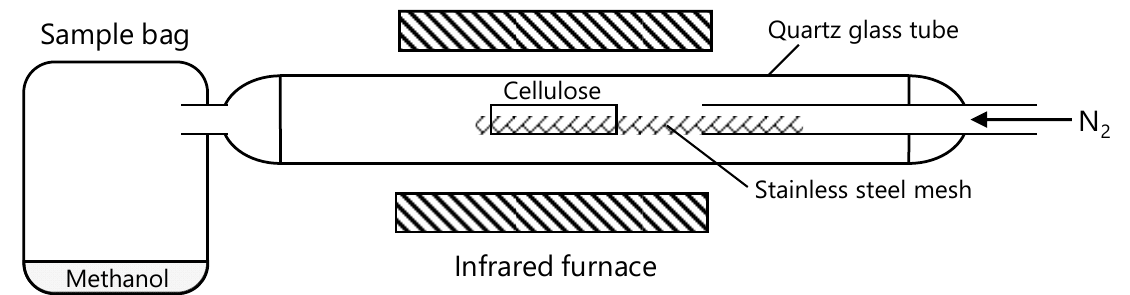
Figure 1. The fast pyrolysis system incorporating an infrared image furnace used in this study. During the pyrolysis, a colorless mist escaped from the reactor and was captured in the sampling bag, where it collected on the inner walls after standing for 30 min (Figure 2). A 5.0 mL quantity of neon gas was added to the sample bag as an internal standard, after which the contents were analyzed by micro gas chromatography (GC, CP-4900, Varian Inc., Palo Alto, CA, USA). The chromatographic conditions included a 10 m MS5 A column, Ar as the carrier gas, a column temperature of 100 ◦ C, a column pressure of 170 kPa and a thermal conductivity detector (TCD). Using these conditions, the compounds analyzed (and their retention times) were Ne (25.7 s), H 2 (27.0 s), O 2 (35.8 s), CH 4 (60.9 s) and CO (79.8 s) (Figure S1A). A second channel on the instrument included a 10 m PoraPLOT Q column with He as the carrier gas, a column temperature of 80 ◦ C, a column pressure of 190 kPa and a TCD. The associated analytes (and retention times) were CO 2 (19.3 s), C 2 H 4 (22.6 s), C 2 H 6 (25.3 s) and C 3 H 6 (53.5 s) (Figure S1B).